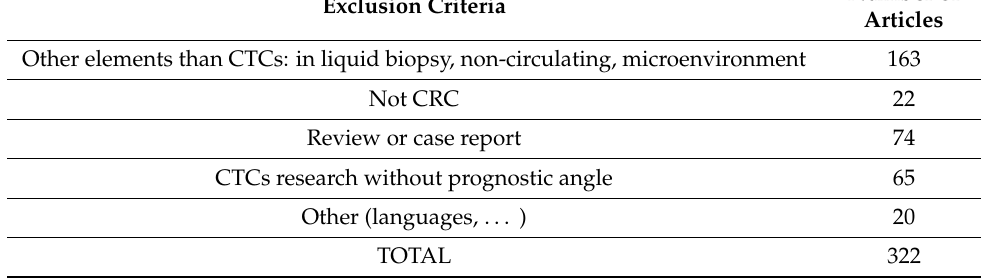
Table 1. Exclusion criteria.